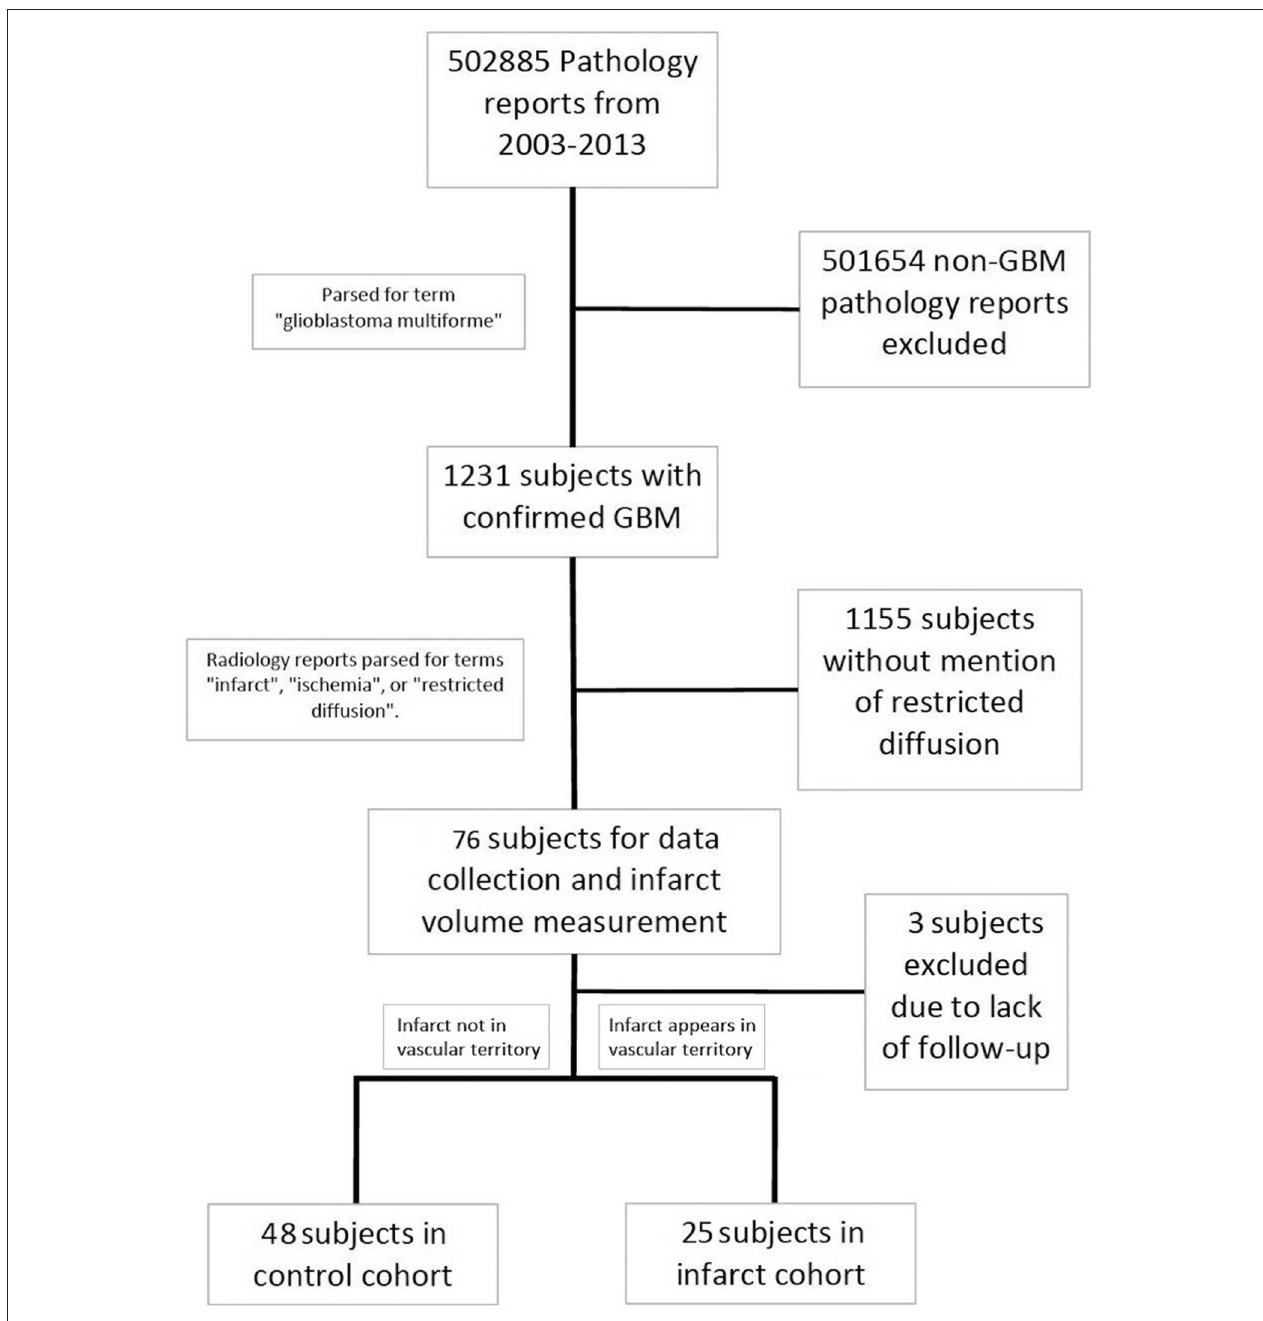
FIGURE 1 | Process used to build study